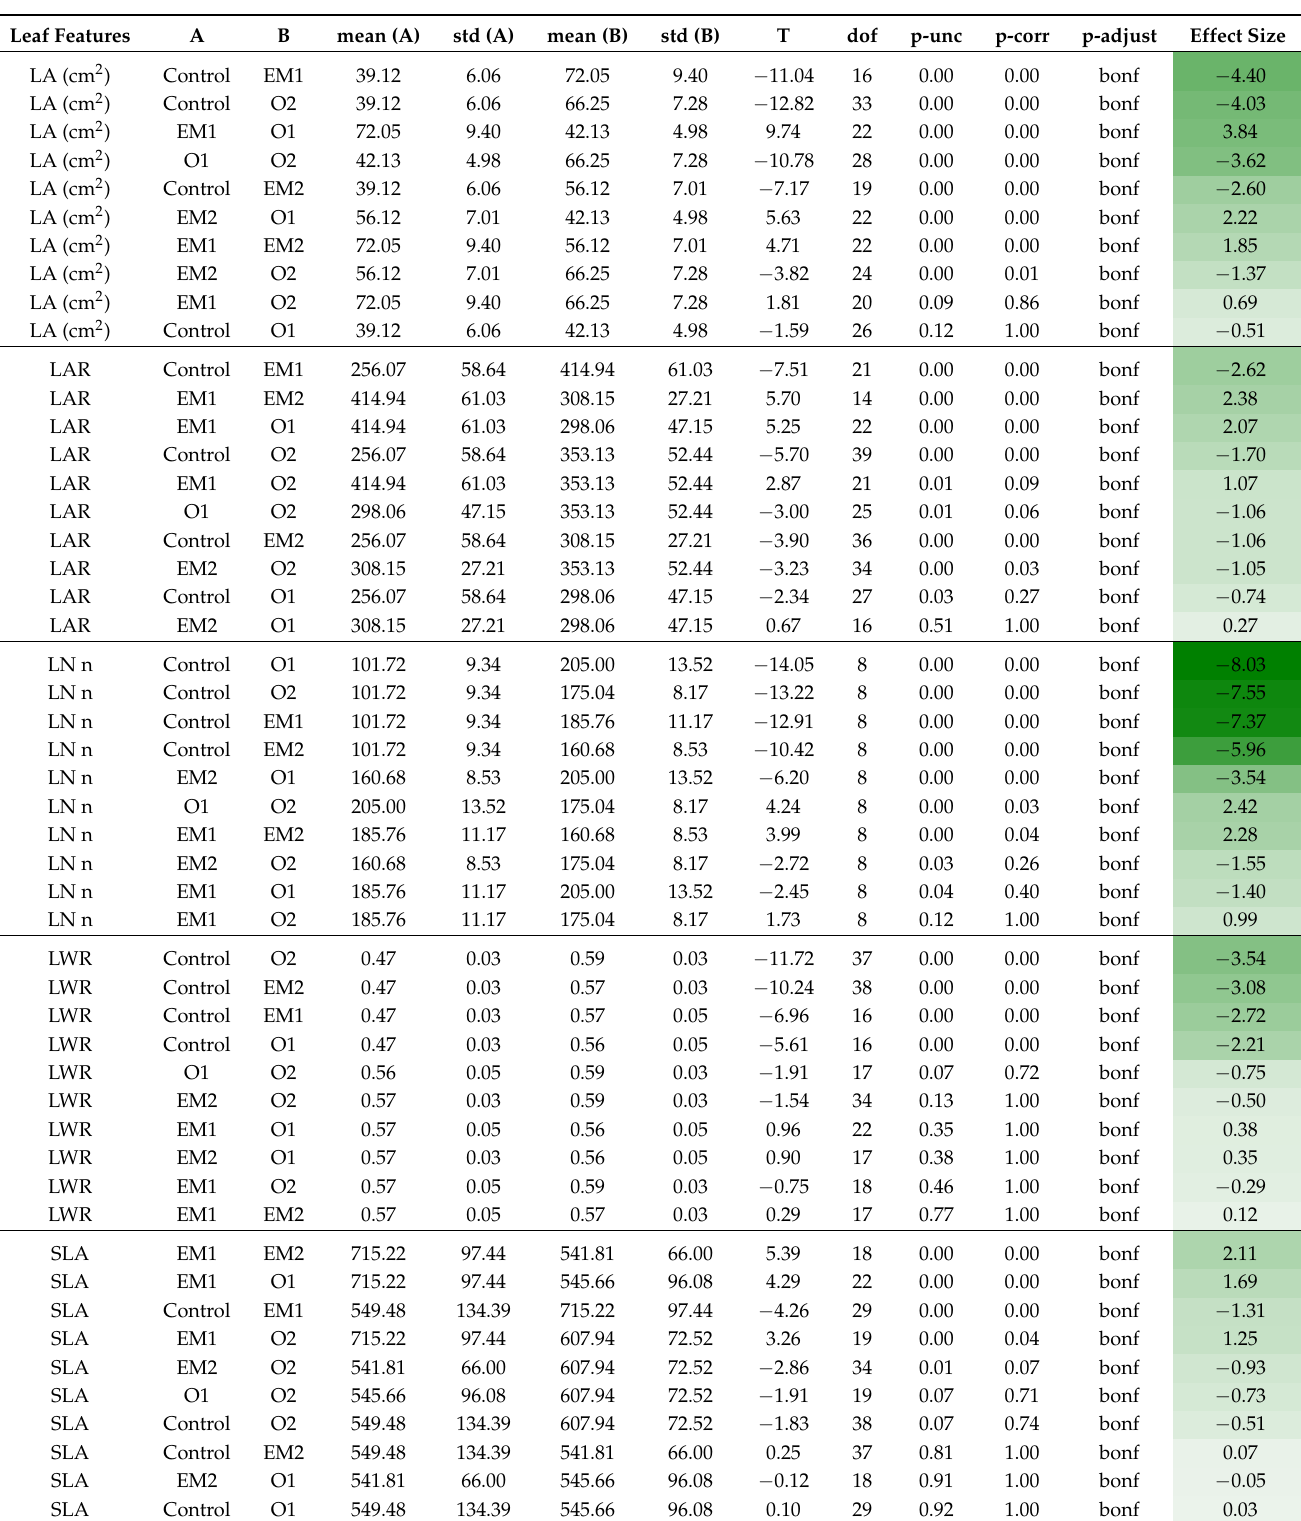
Table A3. Treatments pairwise analysis for